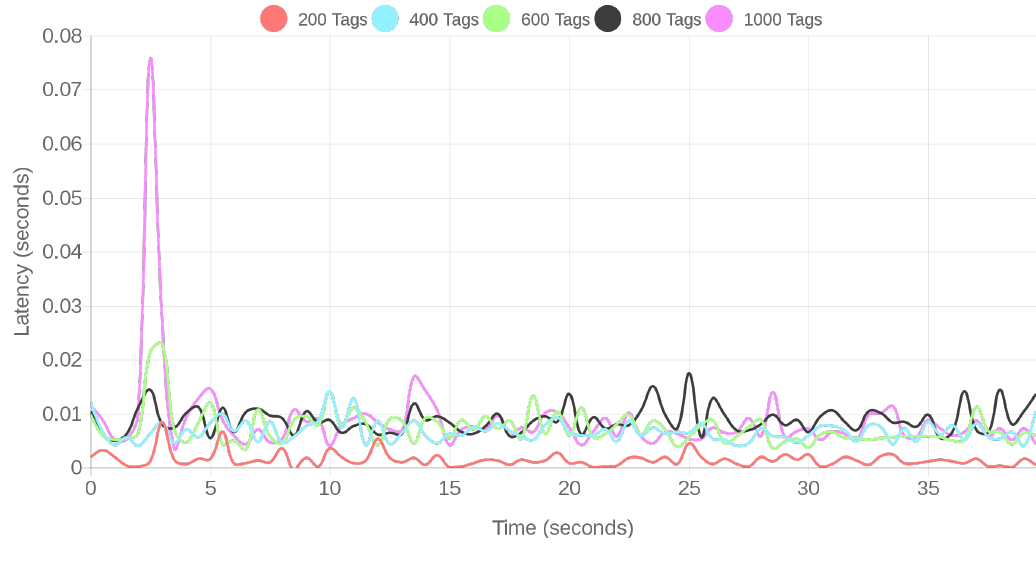
Figure 19. Latencies for the fog system under regular loads.